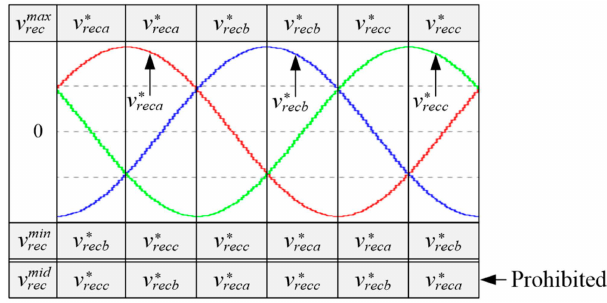
Figure 3. Classification of the rectifier input